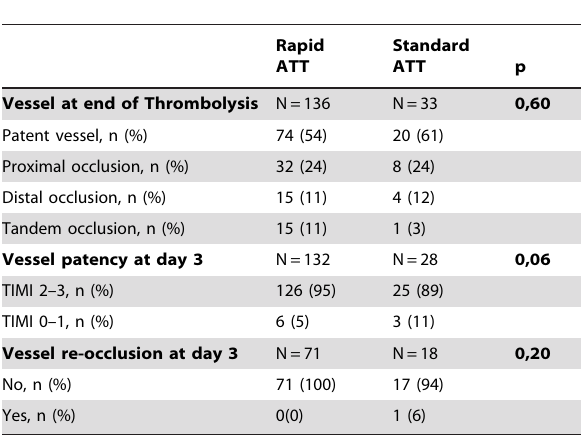
Table 2. Vessel status at baseline and at 72 h in both att